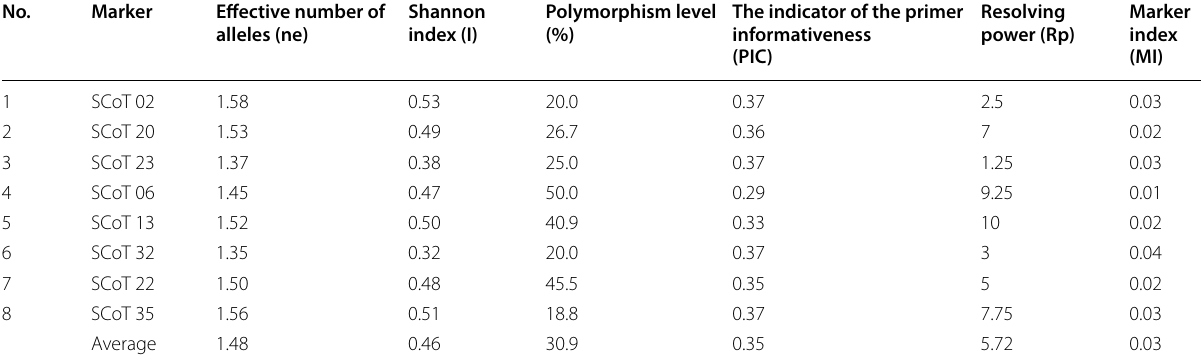
Table 3 Indicators of genetic variability and information content of SCoT markers based on the analysis of Russian ryegrass cultivars No.